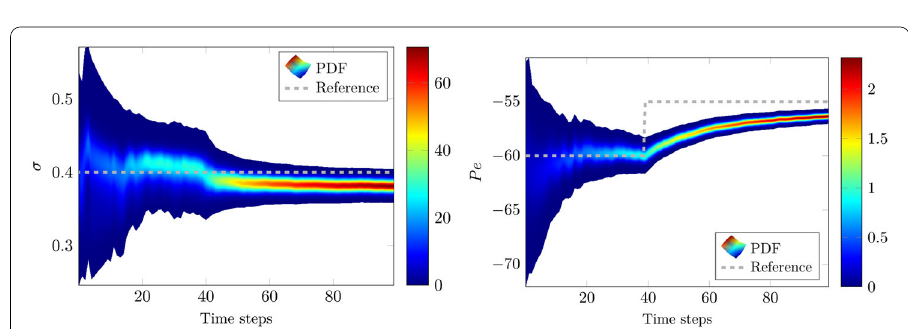
Fig. 18 Marginals on σ (left) and Pe (right) at each assimilation time time step - Case 2